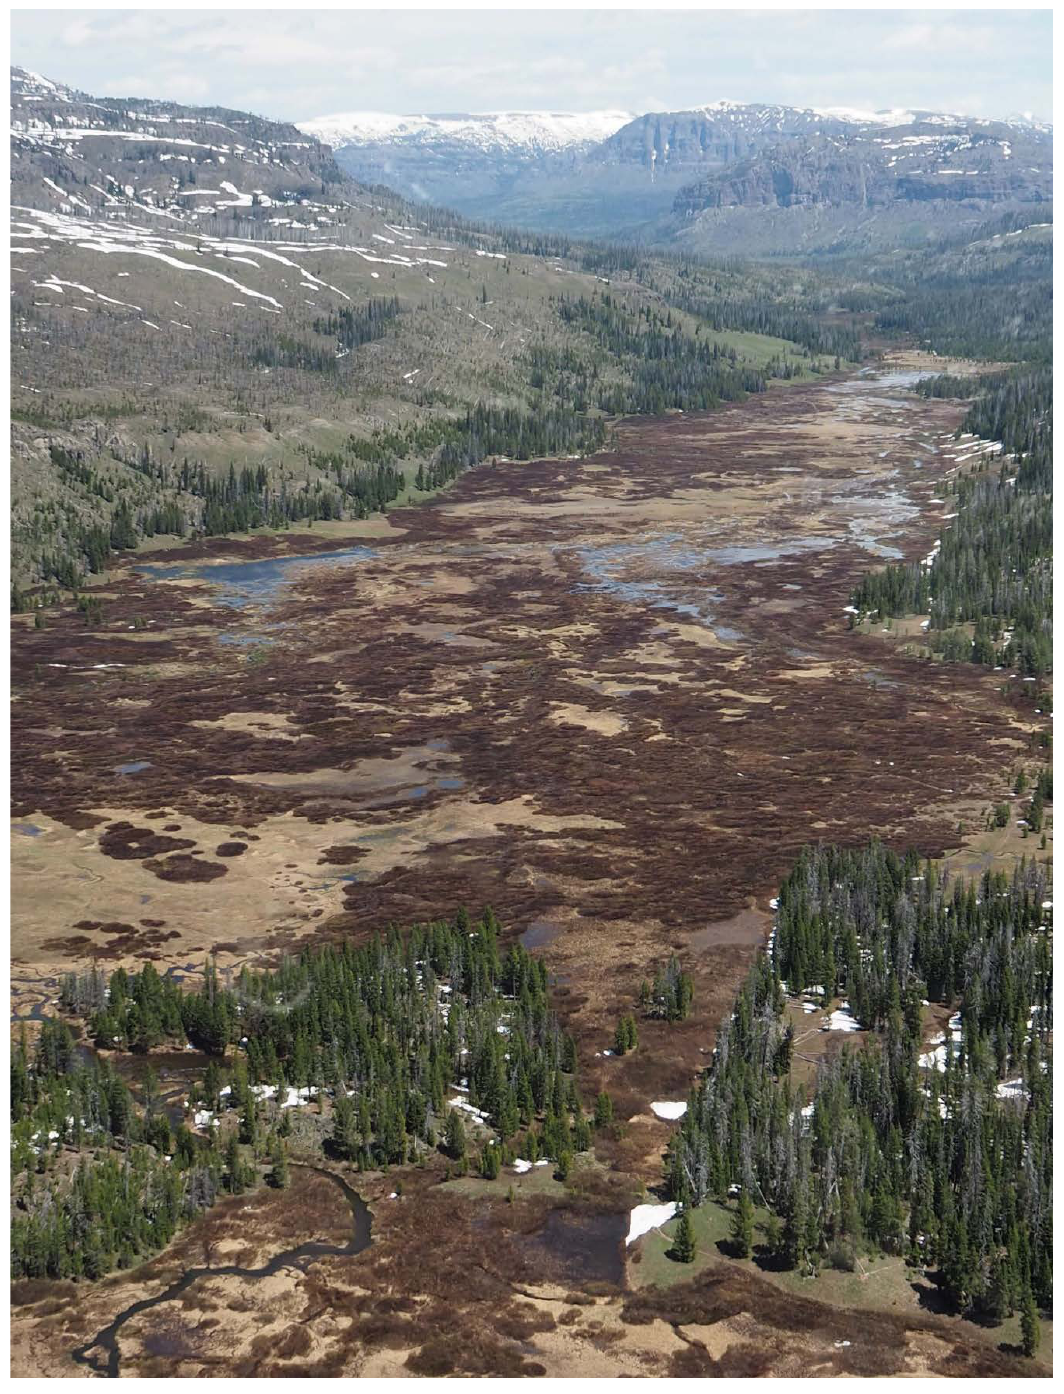
Figure A4. Two Ocean Pass partially flooded following snowmelt run-off in June 2018. Photo is looking east, with Pacific Creek in the foreground and with Atlantic Creek and the Thorofare region (Hawks Rest and the Trident Plateau) of the upper Yellowstone River system in the distance.